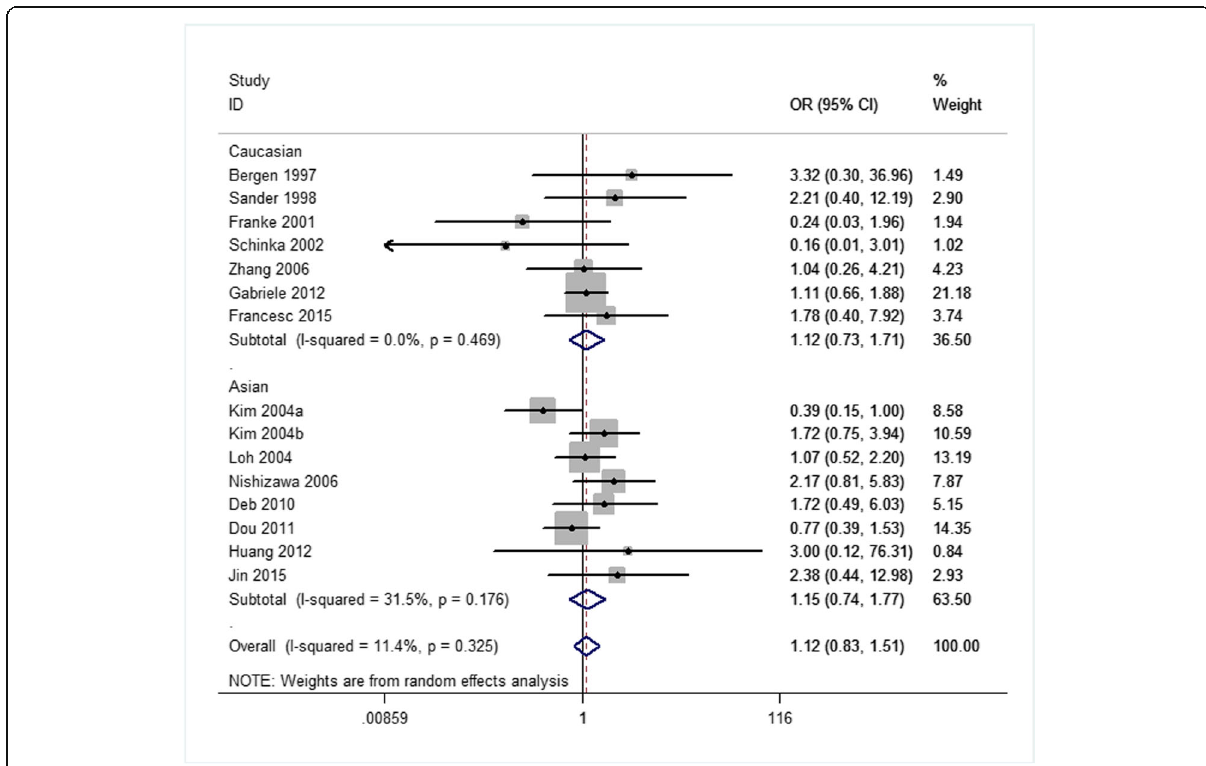
Fig. 4 Forest plots (individual and pooled effects with 95% CI) regarding the association of the OPRM1 A118G polymorphism with alcohol dependence in the homozygote